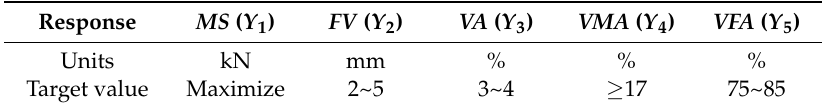
Table 8. Target values of response variables.